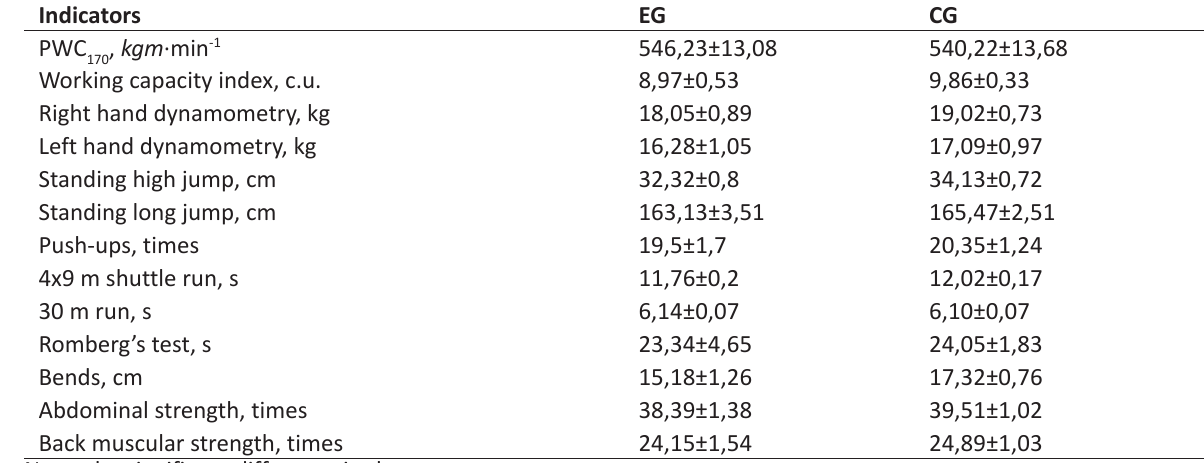
Table 1. Indicators of physical fitness in females of experimental (EG) and control (CG) groups before the forming